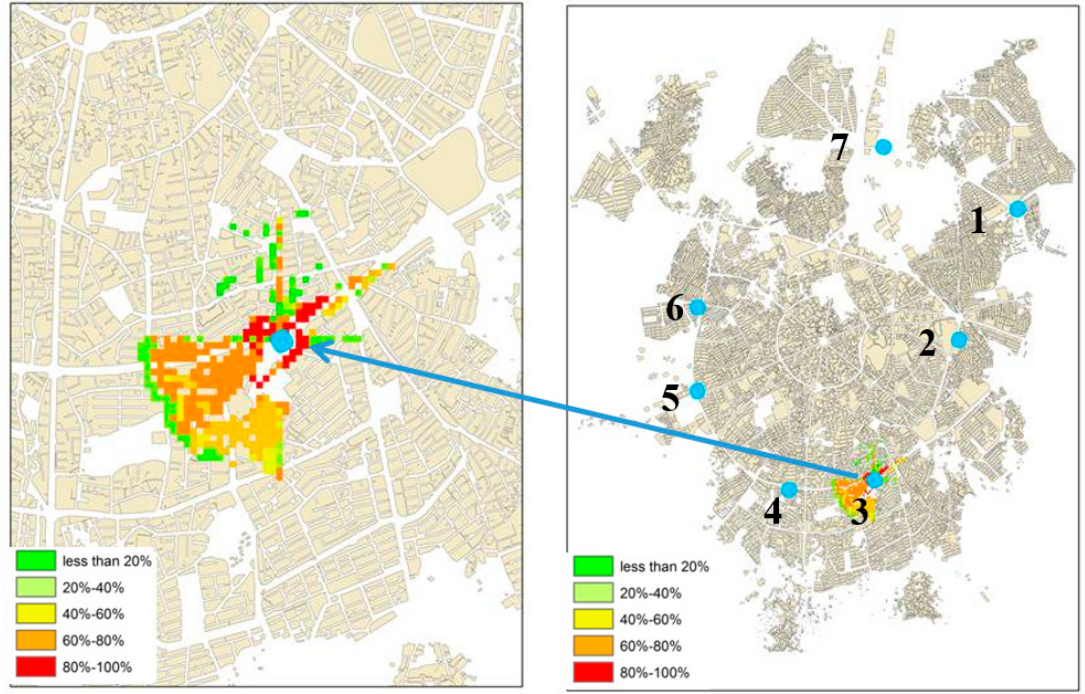
Figure 24. Visibility map of hypothetical tall building No. 3.